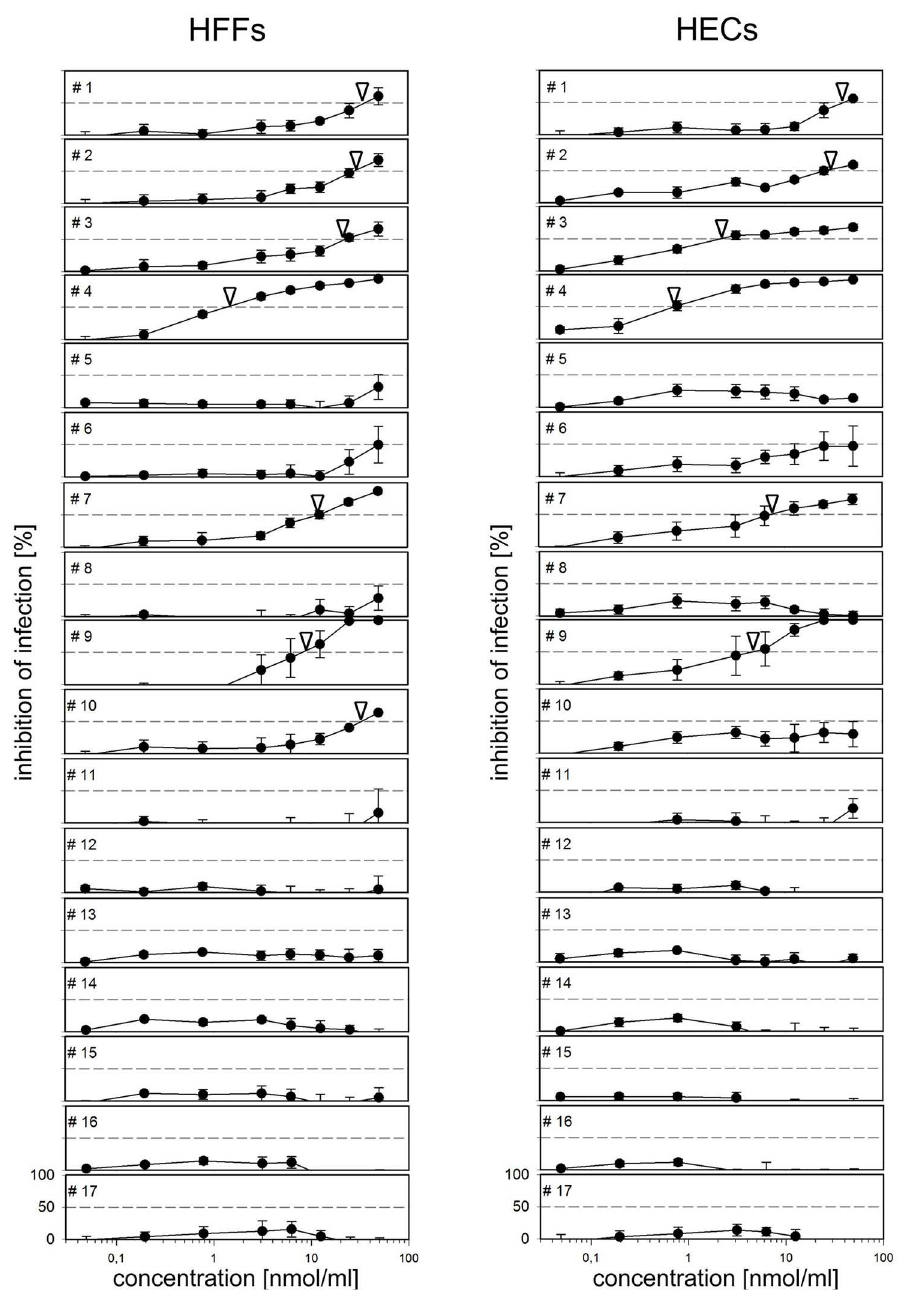
Fig 9. Inhibitory effect of PDGFR-alpha-derived peptides. The luciferase reporter virus TB40-BAC4-IE-Gluc was preincubatedwith 40mer peptides derived from the extracellular domainof PDGFR- alpha at concentrations from 0.05–50nmol/ml for 2 h before infection of fibroblasts (HFFs) and endothelial cells (HECs). Untreatedvirus was used as a control for uninhibitedinfection. One day postinfection, supernatants were analyzedfor luciferase activity indicatingthe degreeof infection. The extent of inhibition was calculatedas 1 - (luminescence with peptide/ luminescence without peptide) and is given as percentage. Error bars indicate the standard error of the mean (SEM) of four data sets per peptide. The numberof the peptide(#1-#17)indicatesits positionin the protein, starting from the N-terminus. Arrowheadsindicate the concentration at which 50% of infection are